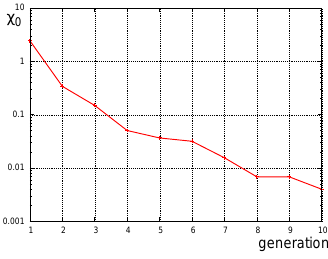
Figure 7. Prediction error χ 0 for three-equation Galerkin model with Floquet calibration of l + ij and q + ijk terms in consecutive iterations of genetic